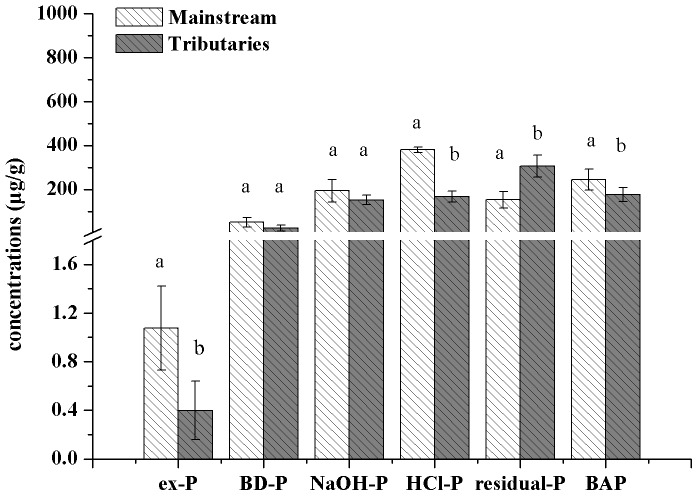
Average concentrations of P fractions in the sediments of mainstream and tributaries.(Different letters indicate significant differences among the mainstream and the tributaries at the 0.05 level).